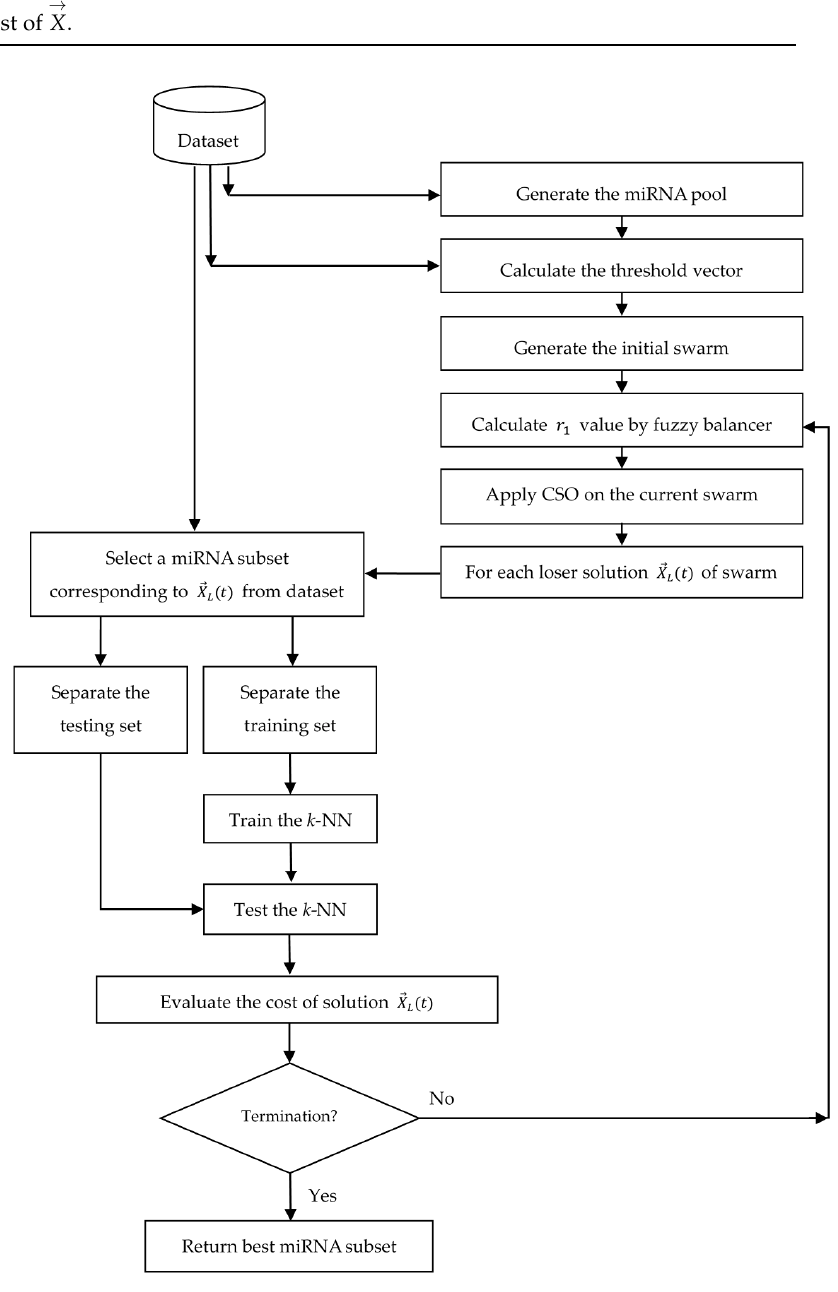
Figure 4. System architecture of the proposed algorithm for miRNA subset selection.